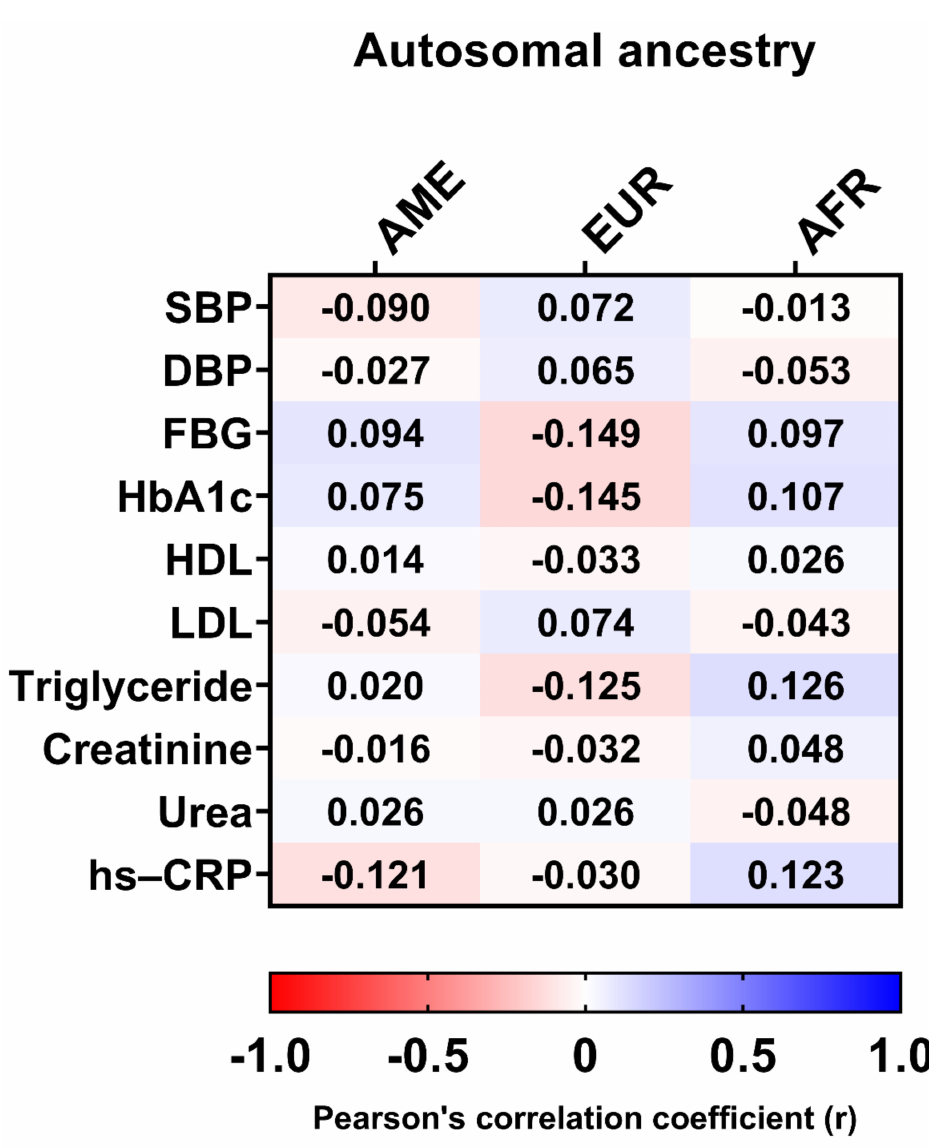
Figure 6. Pearson’s correlation coefficients between clinical data and autosomal ancestry. AME, Amerindian; EUR, European; AFR, African; SBP, systolic blood pressure; DBP, diastolic blood pressure; FBG, fasting blood glucose; HbA1c, glycated hemoglobin; HDL, high-density lipoprotein; LDL, low-density lipoprotein; hs-CRP, high-sensitivity C-reactive